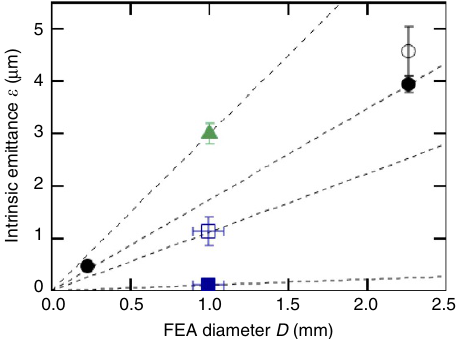
d F ¼ 0.19 ± 0.01 eV. This is in good agreement with E t h i obtained